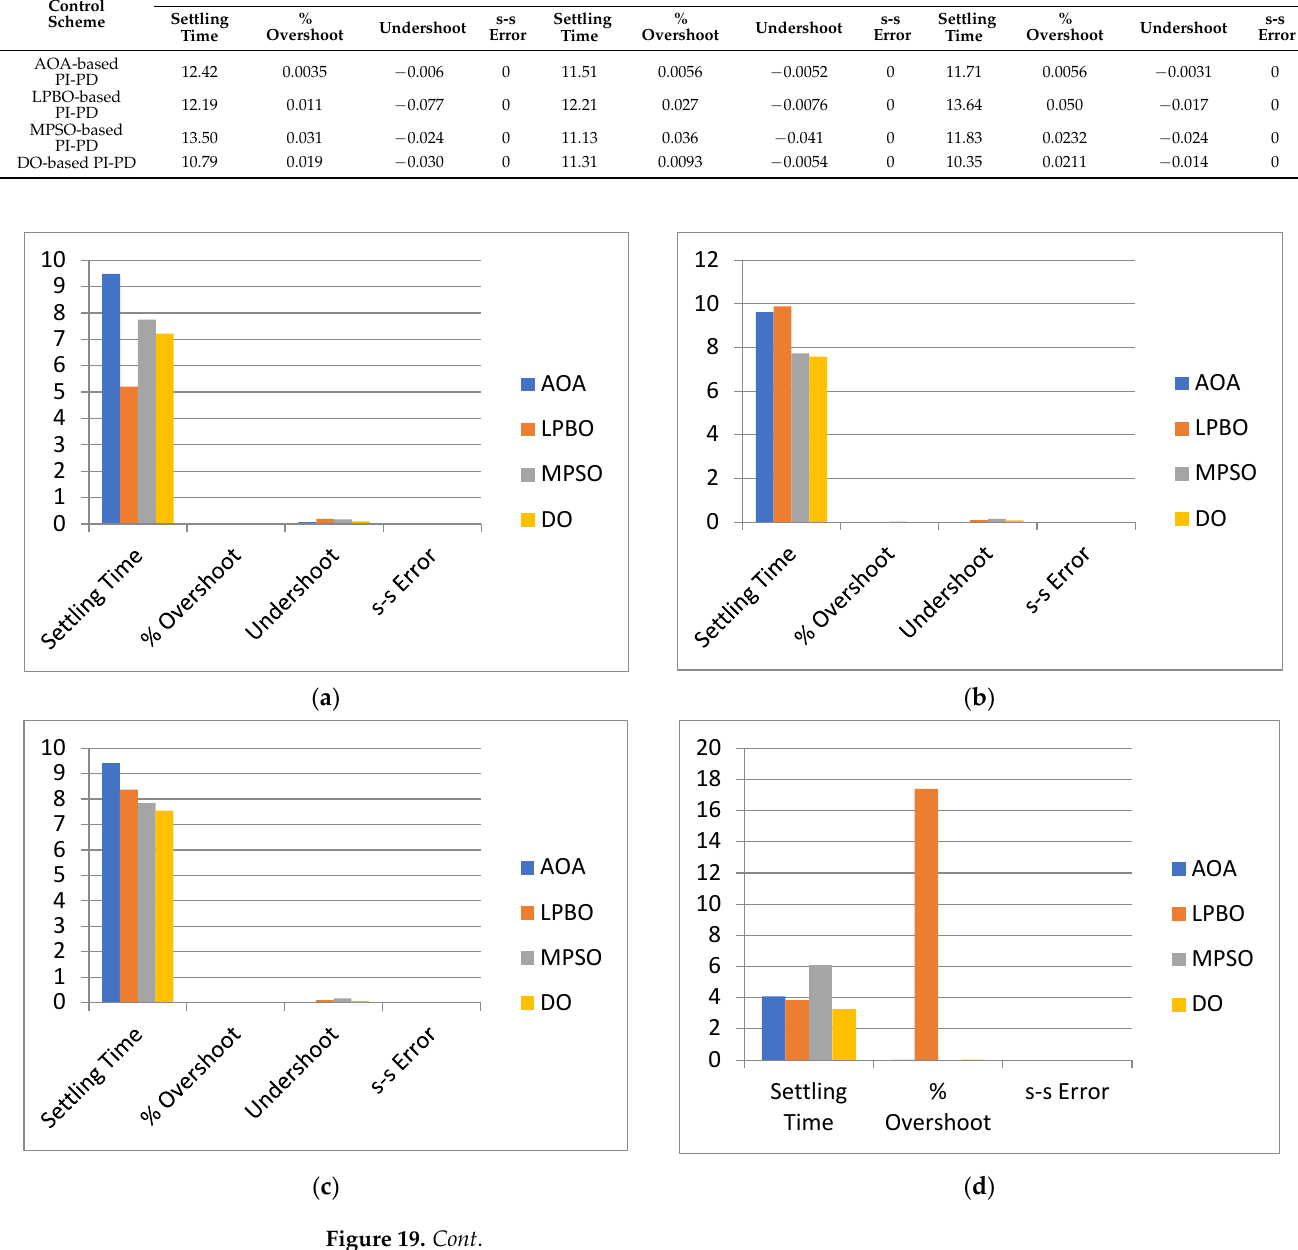
Table 15. Numerical results of tie-line power deviation in a three-area multi-source IPS with non- linearities.